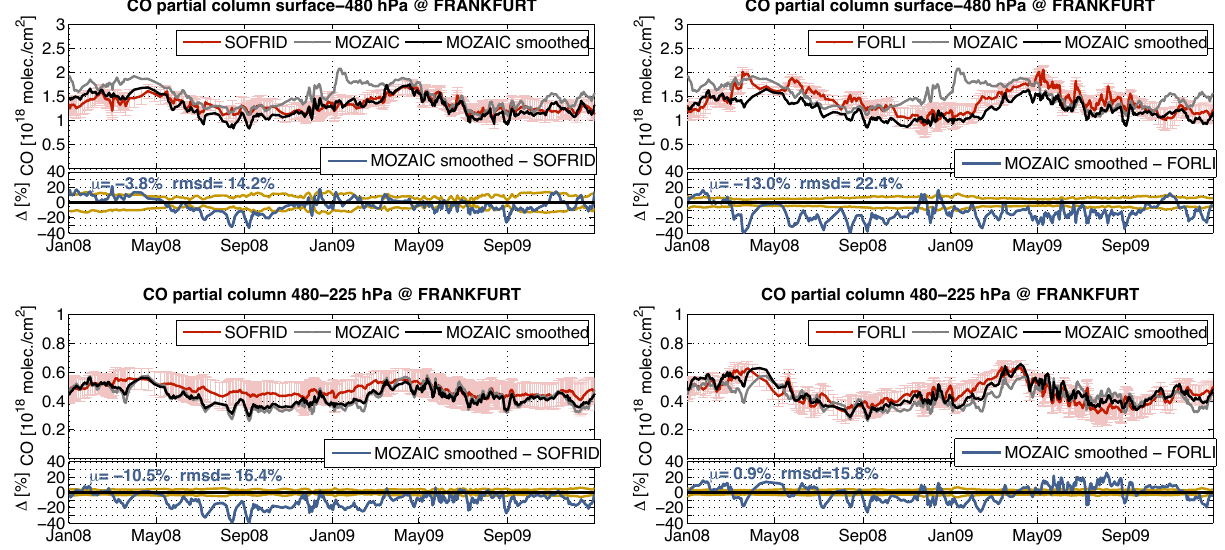
Fig. 5. Temporal variation of lower (surface–480hPa) (top panels) and upper tropospheric (480–225hPa) (bottom panels) partial columns at Frankfurt of MOZAIC versus SOFRID (left panels) and FORLI (right panels). IASI-retrieved partial columns are given in red, MOZAIC partial columns in grey and MOZAIC data smoothed with the averaging kernels of the respective IASI algorithm (SOFRID left, FORLI right) in black. The pink vertical bars represent the IASI partial column retrieval error. The relative difference between smoothed MOZAIC and IASI (MOZAIC-IASI/((MOZAIC+IASI)/2), in percentage) is given below each figure in blue, with its mean ( µ ) and root-mean-square (rmsd). The ochre contours represent the IASI measurement error. The data are smoothed by a 5-point moving average.